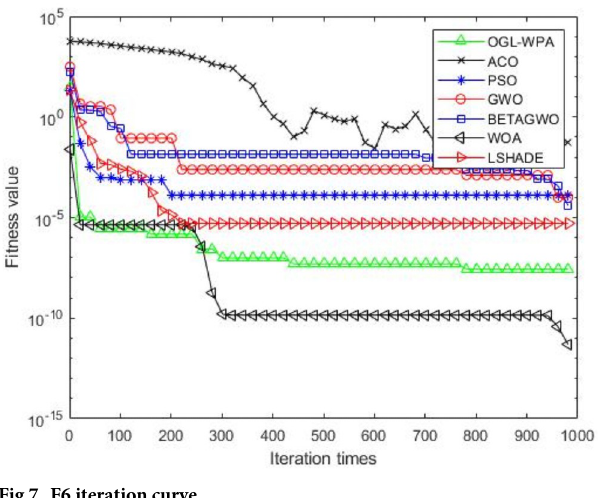
Fig 7. F6 iteration